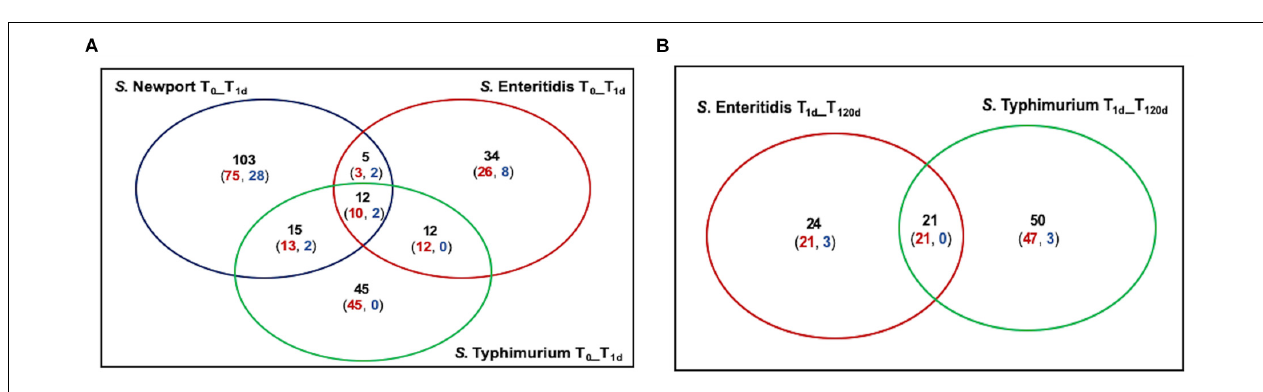
FIGURE 2 | The relative abundance of mutants after selection in pistachios. (A) S. Enteritidis P125109 mutant library on pistachios after drying for 1 day (T 1d ) relative to immediately after inoculation (T 0 ); (B) S. Enteritidis P125109 mutant library on pistachios at 120 days of storage (T 120d ) relative to T 1d ; (C) S. Typhimurium 14028s mutant library on pistachios at T 1d relative to T 0 ; (D) S. Typhimurium 14028s mutant library on pistachios at T 120d relative to T 1d ; (E) S. Newport C4.2 mutant library on pistachios at T 1d relative to T 0 . Red dots indicate significant ( P < 0.05) reduction by at least two-fold, blue dots indicate significant ( P < 0.05) increase by at least two-fold, and black dots indicate non-significant and/or less than two-fold change in abundance. Data represent the average of three independent trials and duplicate samples per trial ( n = 6). Some genes that are consistently under selection and discussed in the text are annotated.